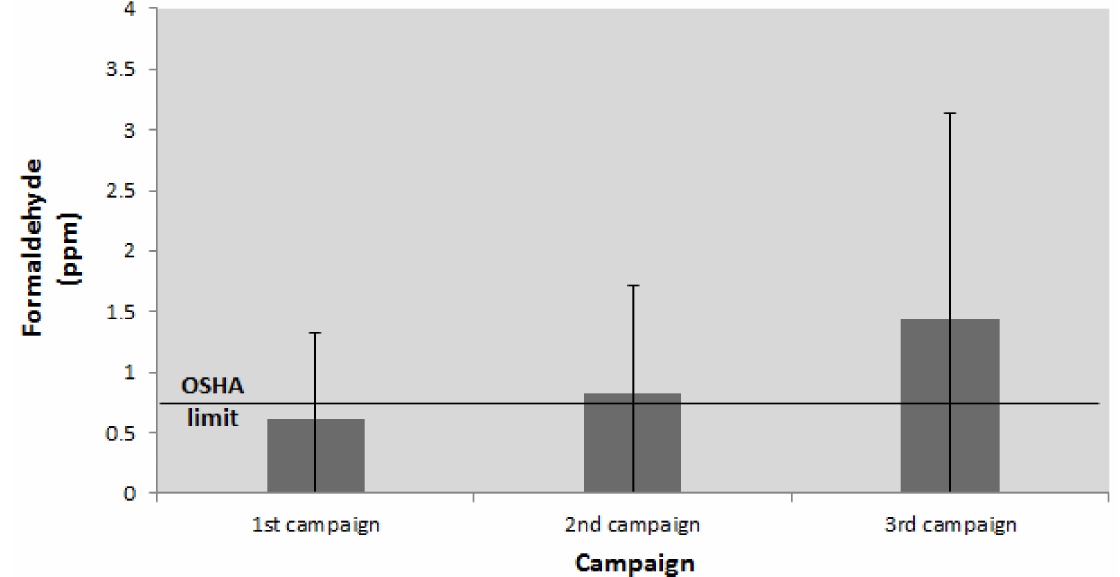
Figure 4. The average FA concentrations during the sampling